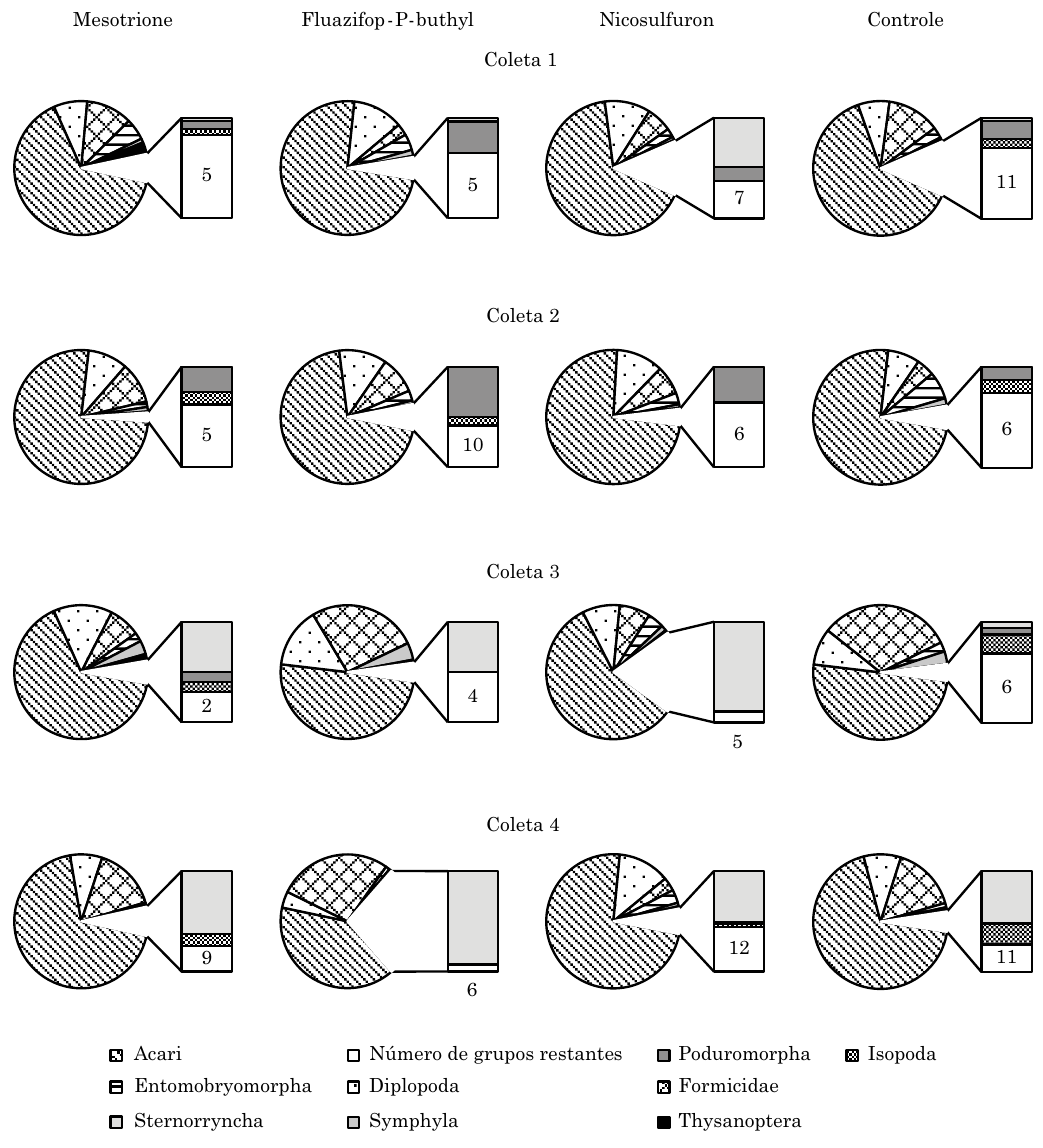
figura 1. distribuição dos principais grupos da comunidade da fauna do solo em área experimental de restauração florestal submetida à aplicação de herbicidas pós-emergentes. Coleta 1 realizada seis dias antes da 2ª aplicação dos herbicidas. coletas 2, 3 e 4 realizadas um, oito e 22 dias, após a 2ª aplicação dos herbicidas,